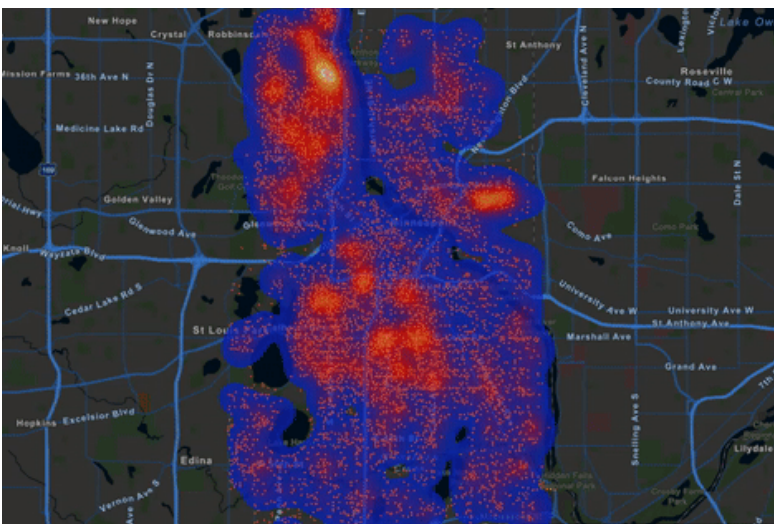
Figure 5. An example of heat map analysis (adapted from